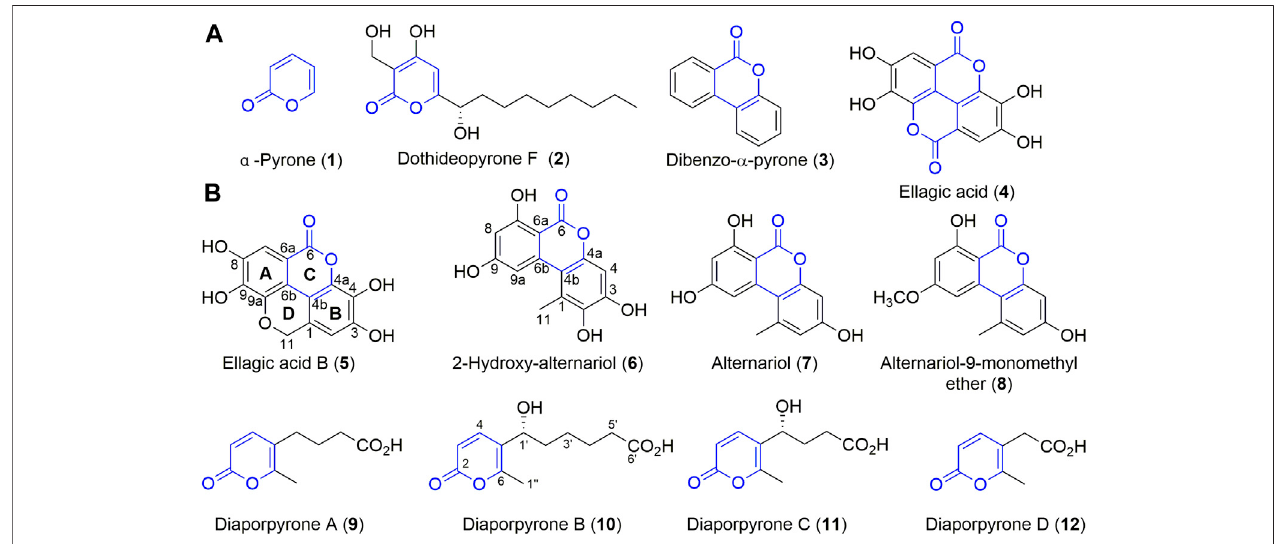
FIGURE 1 | Structures of compounds 1 – 12. (A) The structures of dibenzo- α -pyrones, α -pyrone, and their derivatives. (B) Compounds isolated from endophilic fungus strain Diaporthe sp.